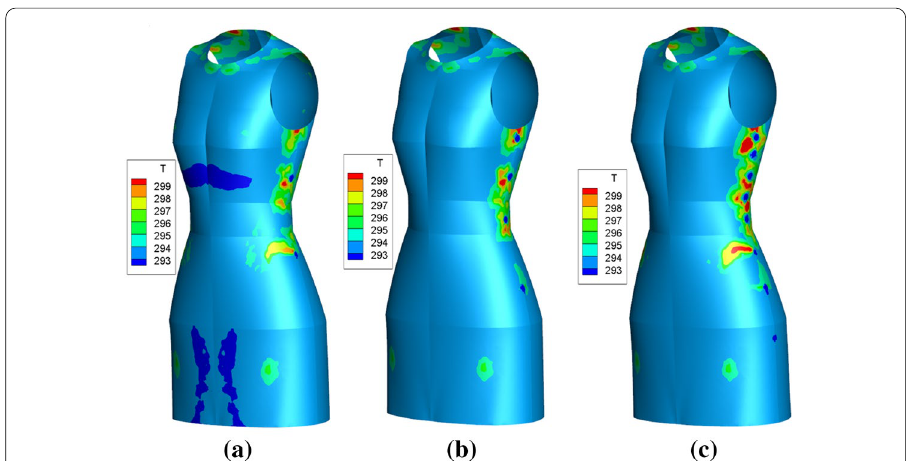
Fig. 5 Temperature contours under various micro-fans type. a Case 1, 2 fans, b case 2, 4 fans, c case 3, 8 fans